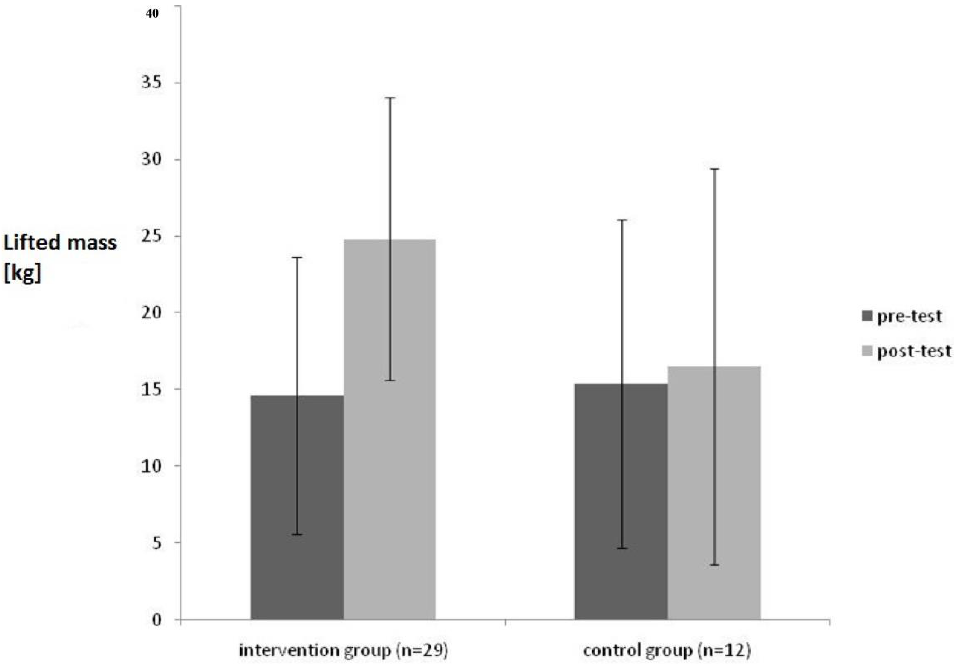
Figure 3. Comparison of the results of the PILE-Test in pre- and post-test condition with (intervention group) and without treatment (control group).